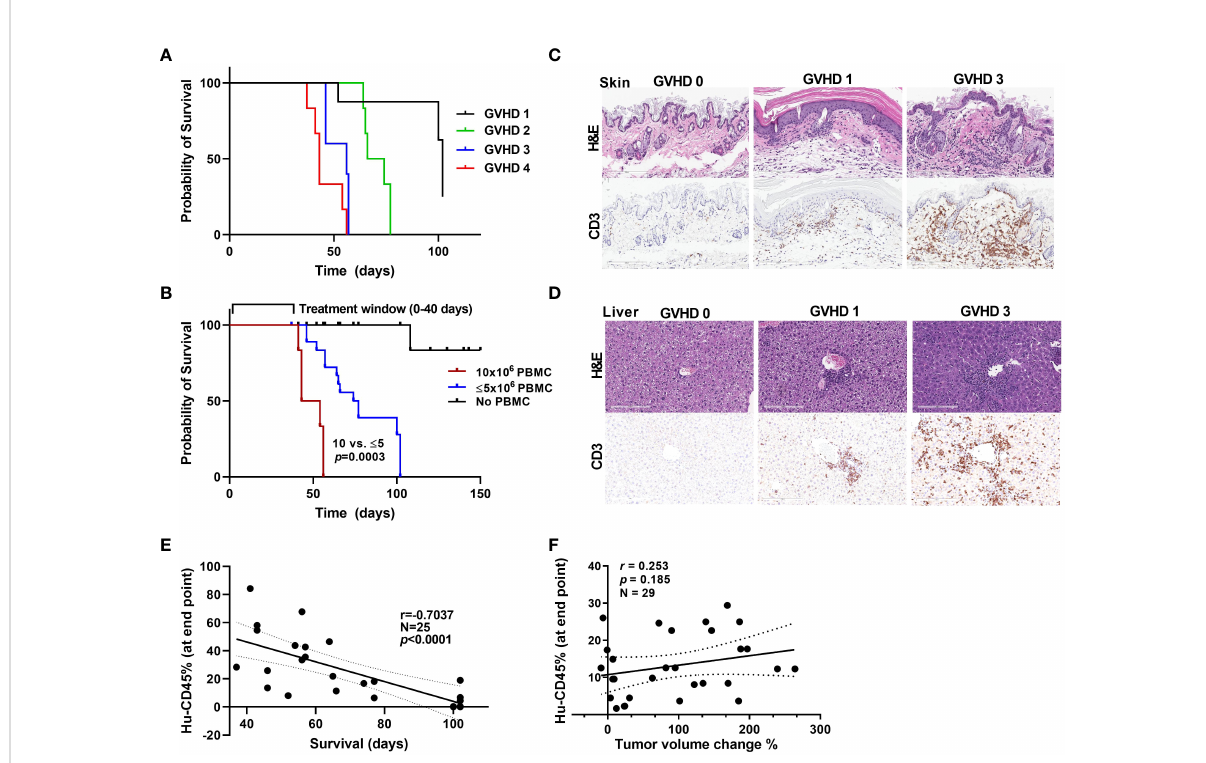
FIGURE 5 GVHD onset and the window of treatment (A) Survival curves for mice based on their GVHD scores. (B) Survival curves for mice that received different numbers of PBMCs. (C, D) Stains showing the level of in fi ltration of human CD3 + cells into mouse skin (C) and liver (D) samples at different stages of GVHD. (E) The correlation between the hCD45 cell percentage in mouse blood at 5 weeks after injection of PBMCs and survival time in mice. (F) The correlation between the hCD45 cell percentage in mouse blood at the experimental end point (at 5 weeks after injection of PBMCs) and percent tumor volume change in anti-PD-1 antibody-treated